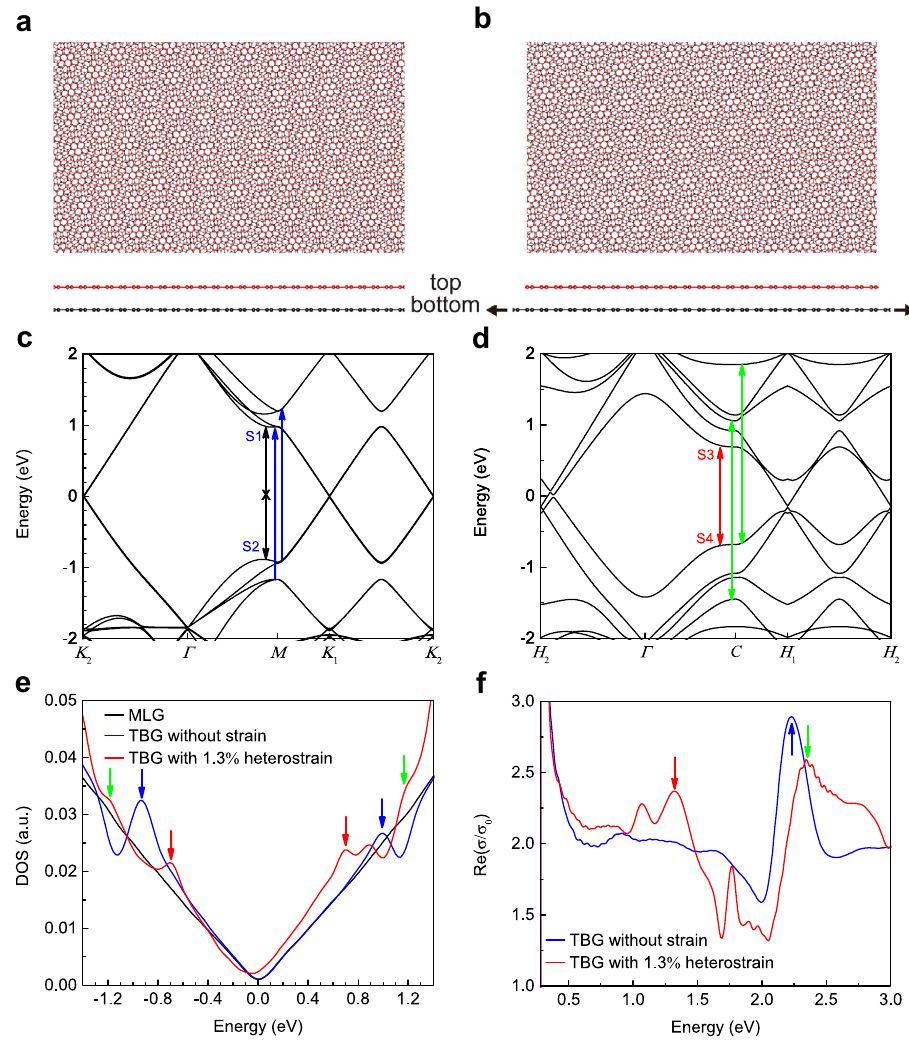
Figure 4. Tight-binding simulations of TBG with and without heterostrain. ( a , b ) Moiré patterns of TBG with 0% and 1.3% heterostrain. ( c , d ) Band structure of TBG with 0% and 1.3% heterostrain. ( e ) DOS of pristine graphene (black), TBG (blue) and TBG under 1.3% heterostrain (red). ( f ) Dynamic conductivity spectra of TBG with (red) and without (blue) heterostrain, which are normalized to pristine